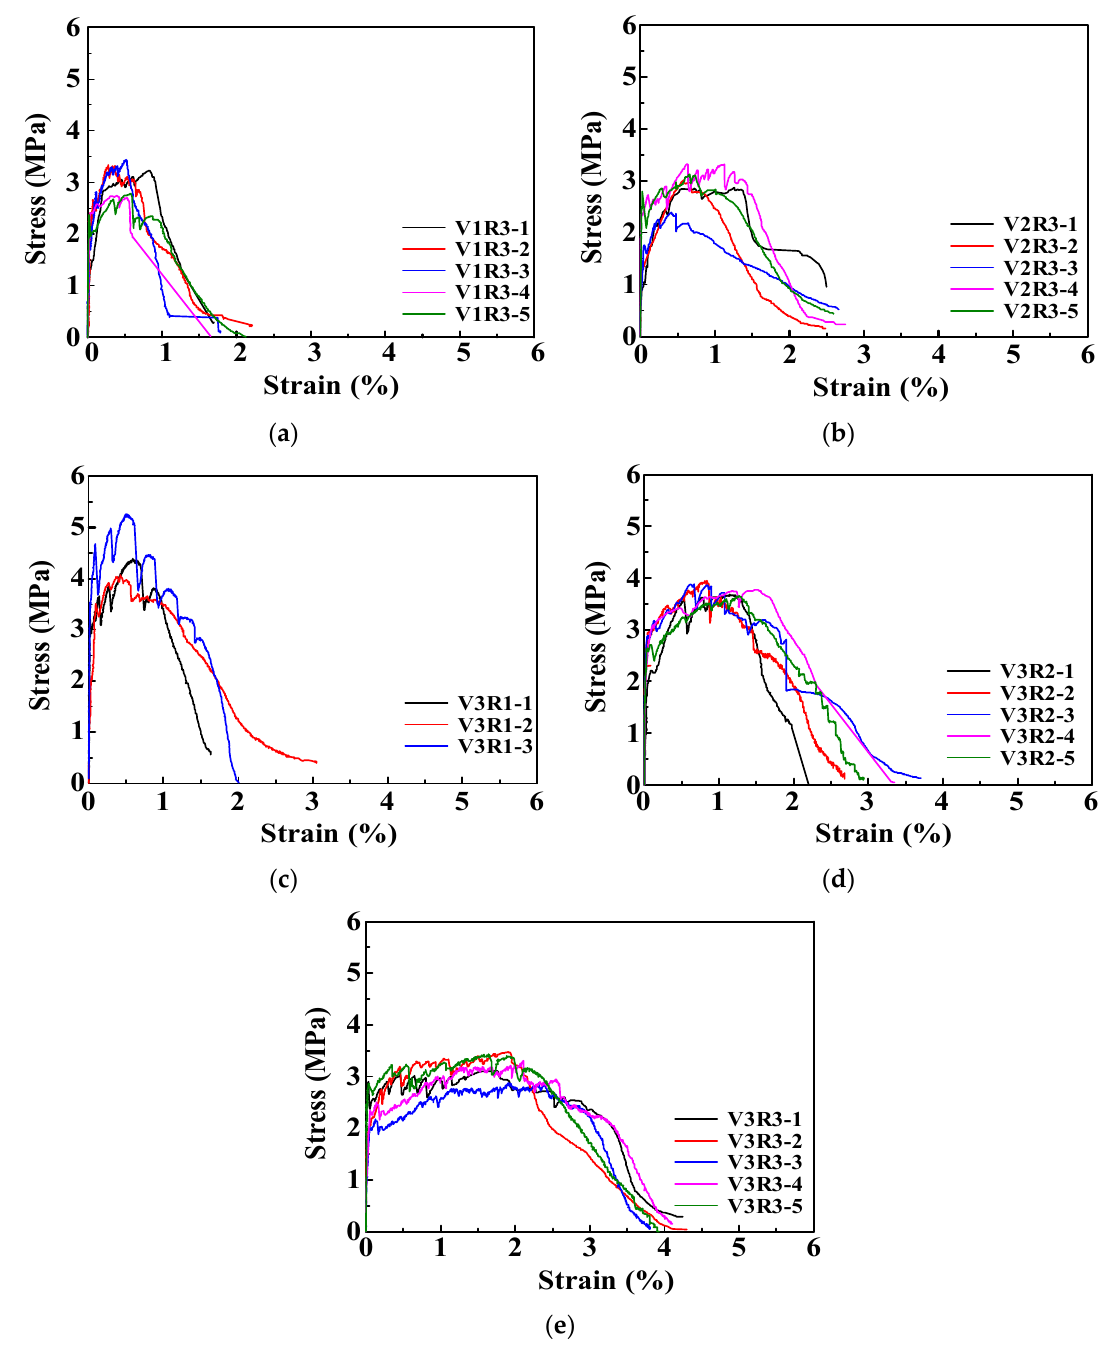
Figure 3. Stress–strain curves of ECC specimens in tension: ( a ) V1R3; ( b ) V2R3; ( c ) V3R1; ( d ) V3R2; ( e ) V3R3.